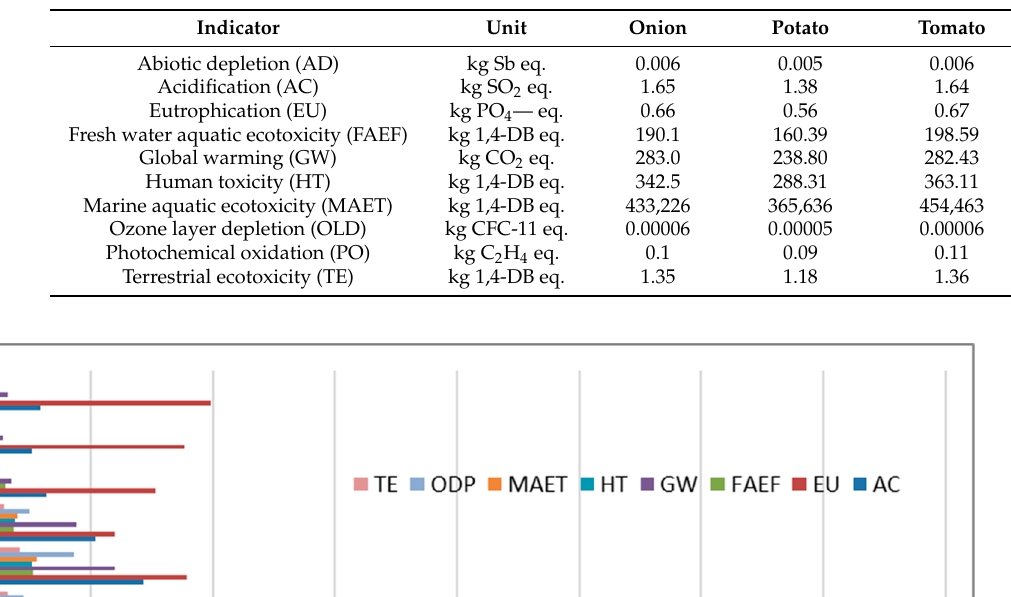
Table 5. Life cycle impact indicators per ton of crop product.